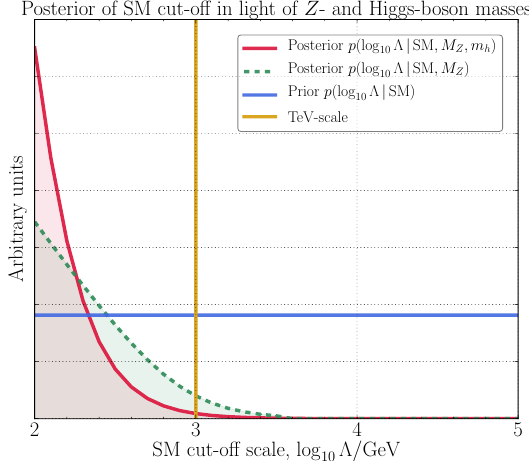
Figure 1. Distribution of log (cid:3), the log of the SM cut-o(cid:11). The prior distribution (blue line) 10 was (cid:13)at in log (cid:3). Once conditioned upon the weak scale ( M exp ), the posterior distribution (green Z dashed line, (cid:12)lled) favors a small SM cut-o(cid:11). This is the gist of the SM hierarchy problem caused by quadratic corrections, (cid:3) 2 . Further conditioning upon m h makes little di(cid:11)erence (red line, (cid:12)lled). A cut-o(cid:11) of (cid:3) = 1 TeV is shown for reference by the vertical (yellow)